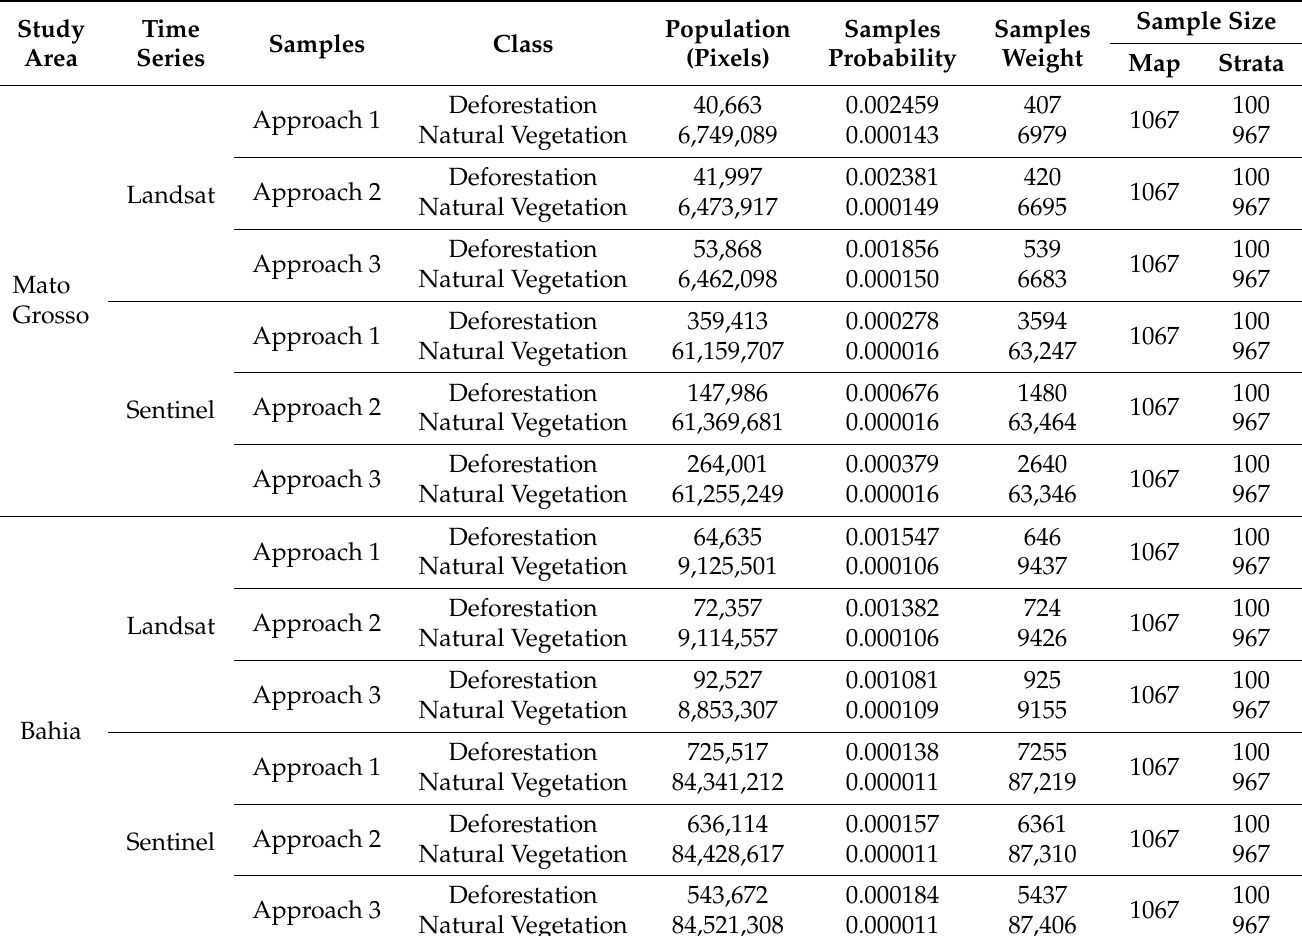
Table 4. Sample probabilities for the validation